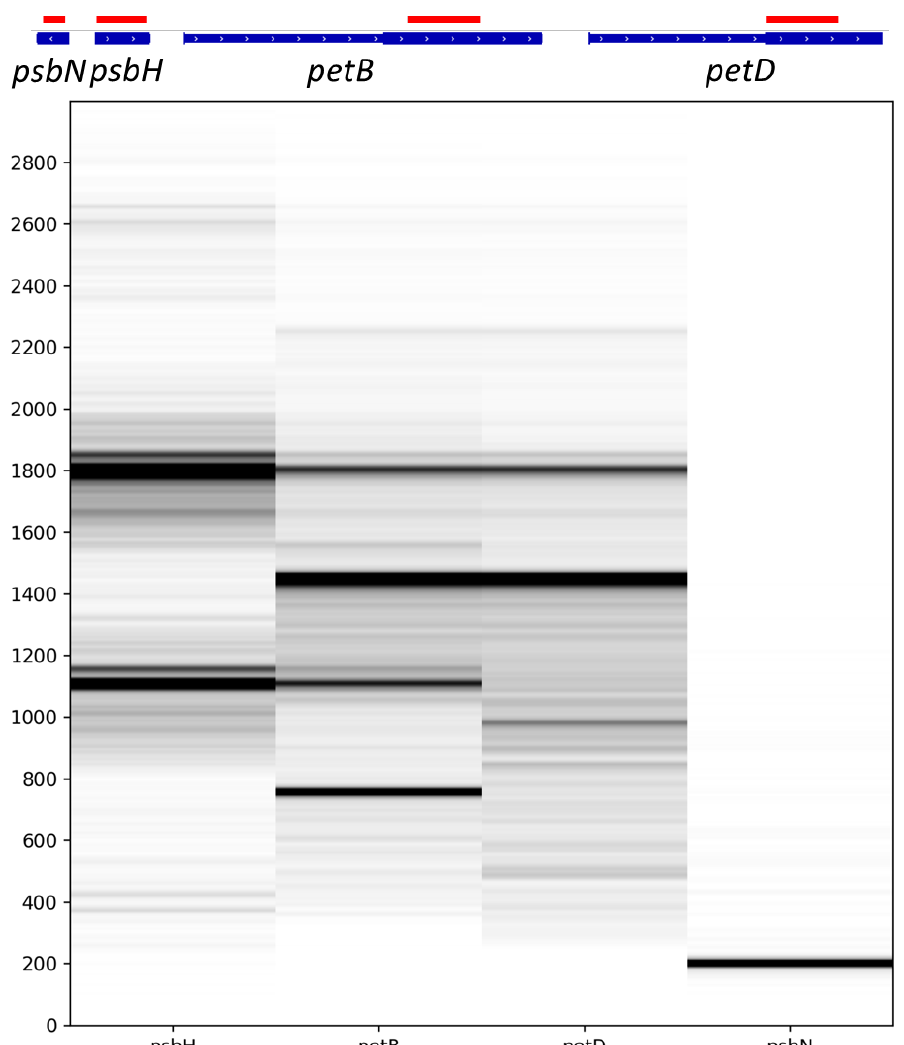
Figure 2. Virtual Northern blots derived from the nanopore sequencing. Northern blots were emulated from nanopore reads mapping to the sequences of psbN , psbH , the second exon of petB , or the second exon of petD shown in red on the genomic map displayed above. The size (in nt) is shown on the left.